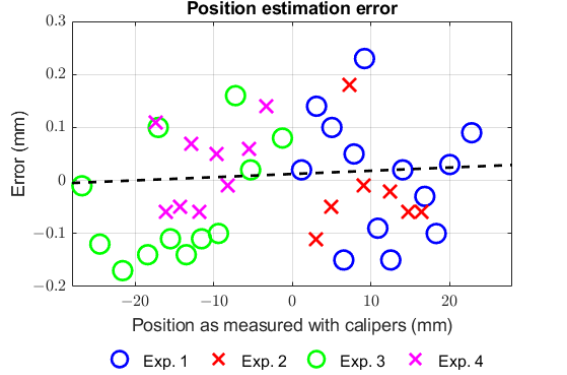
Figure 10. Position estimation error from measurements. The dotted line represents the linear regression.